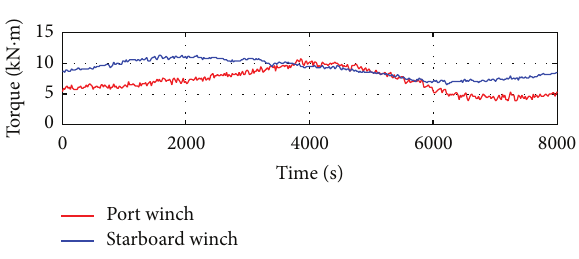
Figure 9: Thrust of the trawler.